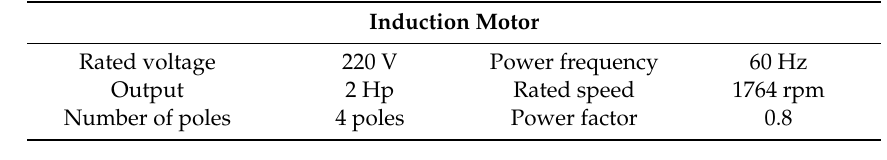
Table 1. Specification of the induction motor.